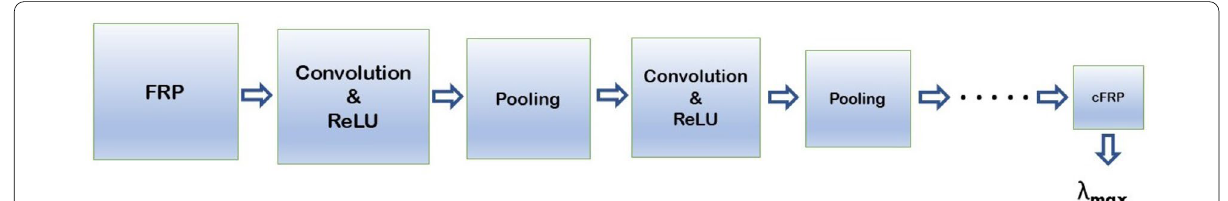
Fig. 1 Process for computing the largest eigenvalue of a convolutional